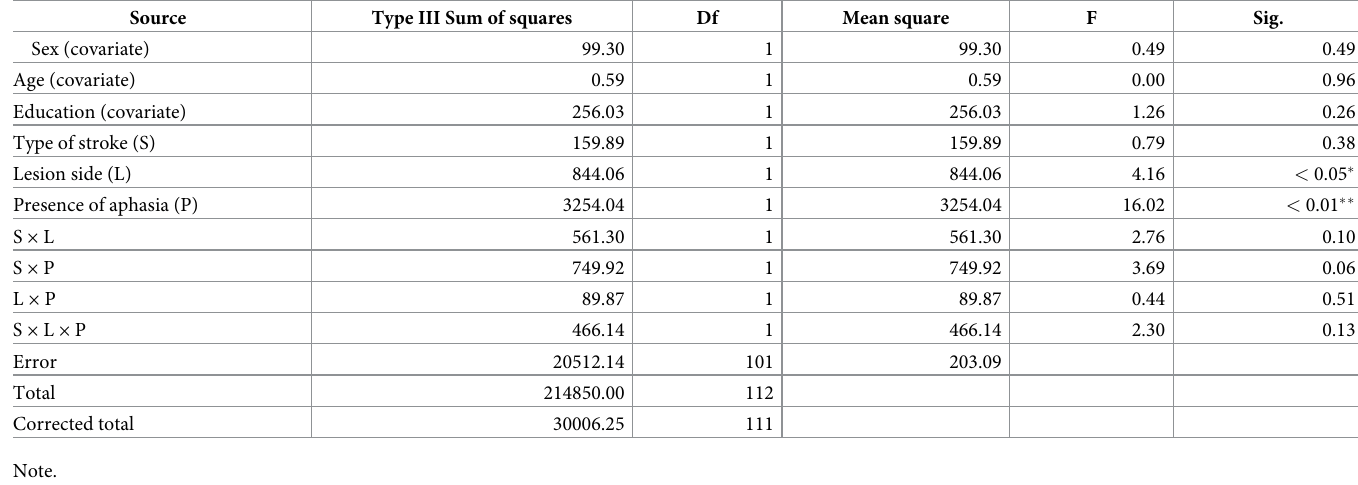
Table 4. Three-way ANCOVA results for total categorical naming test scores in stroke patients (N =